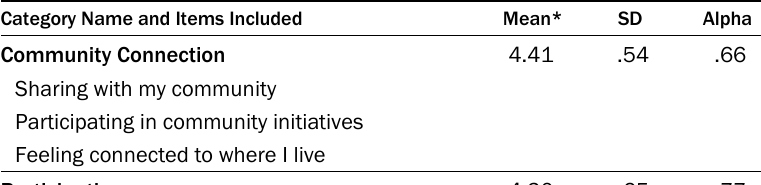
Table 3. Categories of Intrinsic